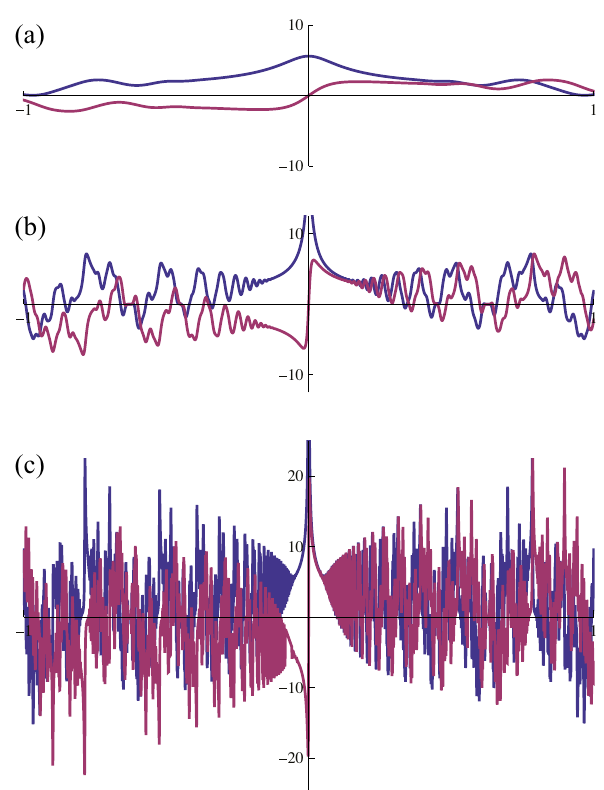
Figure 3. We show the real part (blue curves) and the imaginary part (red curves) of θ 3 ( σ + iε ) for –1 ≤ σ ≤ 1: (a) ε = 0.1; (b) ε = 0.01; (c) ε =